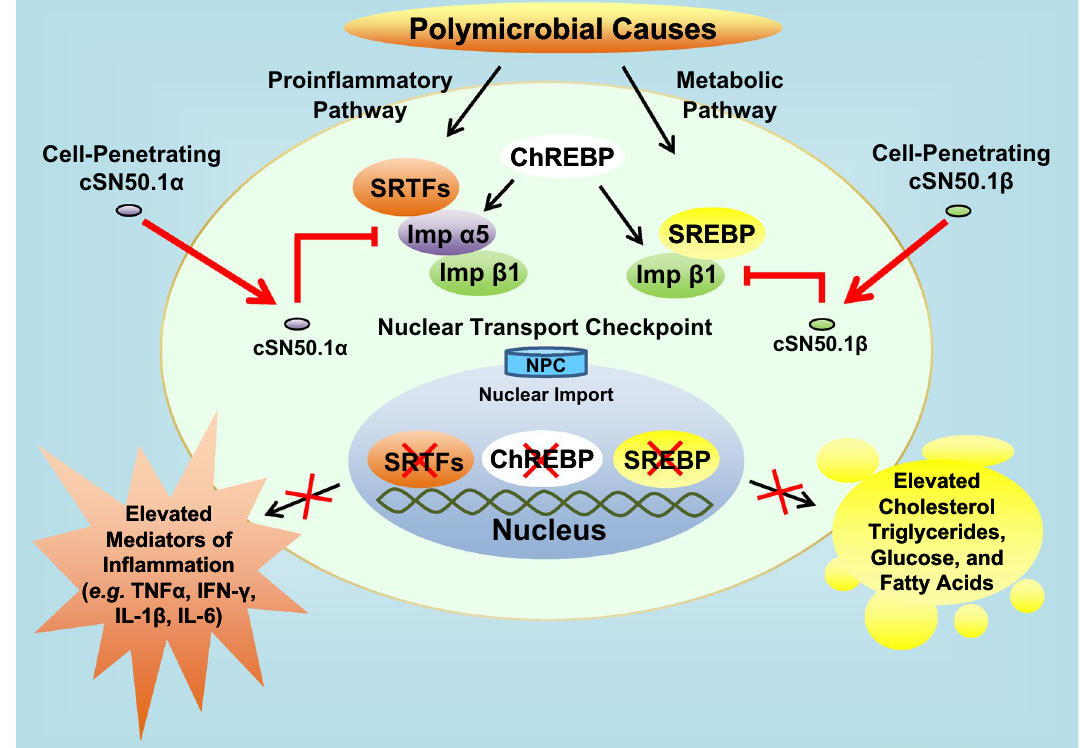
Figure 8. Microbial inflammation is interwoven with metabolic inflammation. Polymicrobial causes (viruses, bacteria, fungi, and protozoa) evoke two signaling pathways (proinflammatory and metabolic). These pathways can be independently targeted by new, pathway selective NTMs, cSN50.1α and cSN50.1β, that respectively bind nuclear transport shuttles, Imp α5 and Imp β1, to modulate Imp α5-mediated nuclear import of